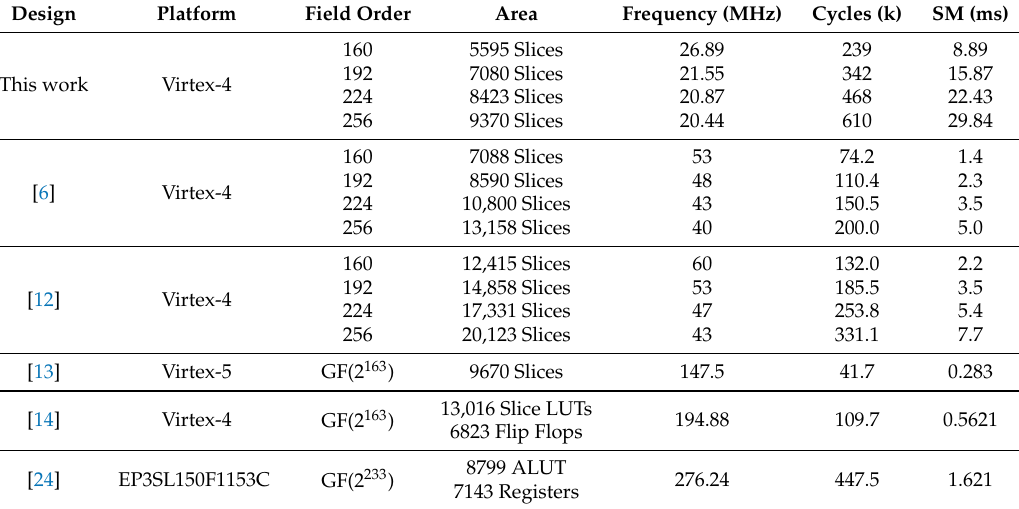
Table 6. colorredECC Hardware Performance Comparison on